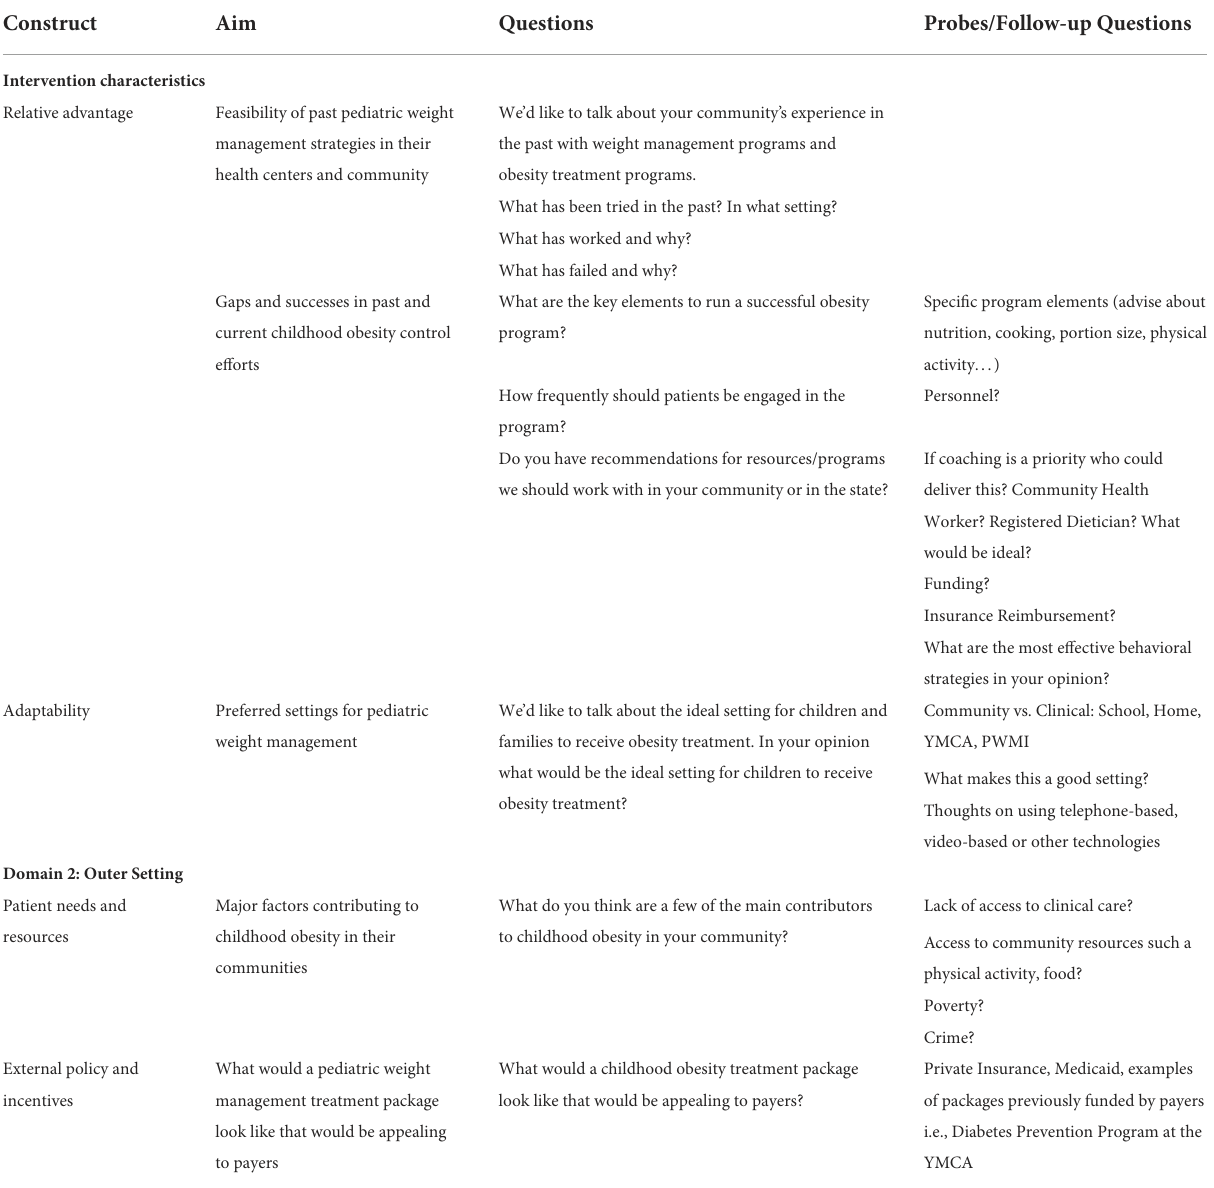
TABLE 2 Interview guide based on CFIR